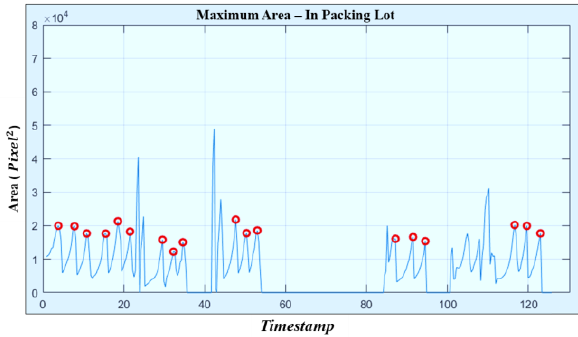
Figure 9. Illustration of the maximum area algorithm for detection Figure 11. The experimental configuration of reference